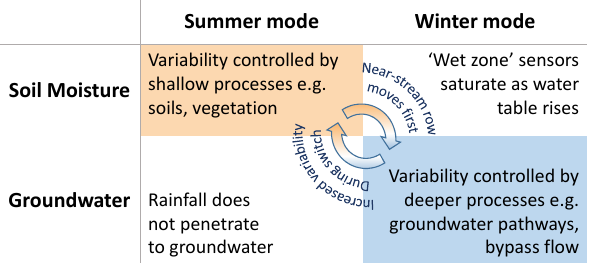
Variability controlled by Groundwater Rainfall does deeper processes e.g. not penetrate to groundwater Figure 13. Schematic diagram of the seasonal cycle of catchment variability between “Summer mode” and “Winter